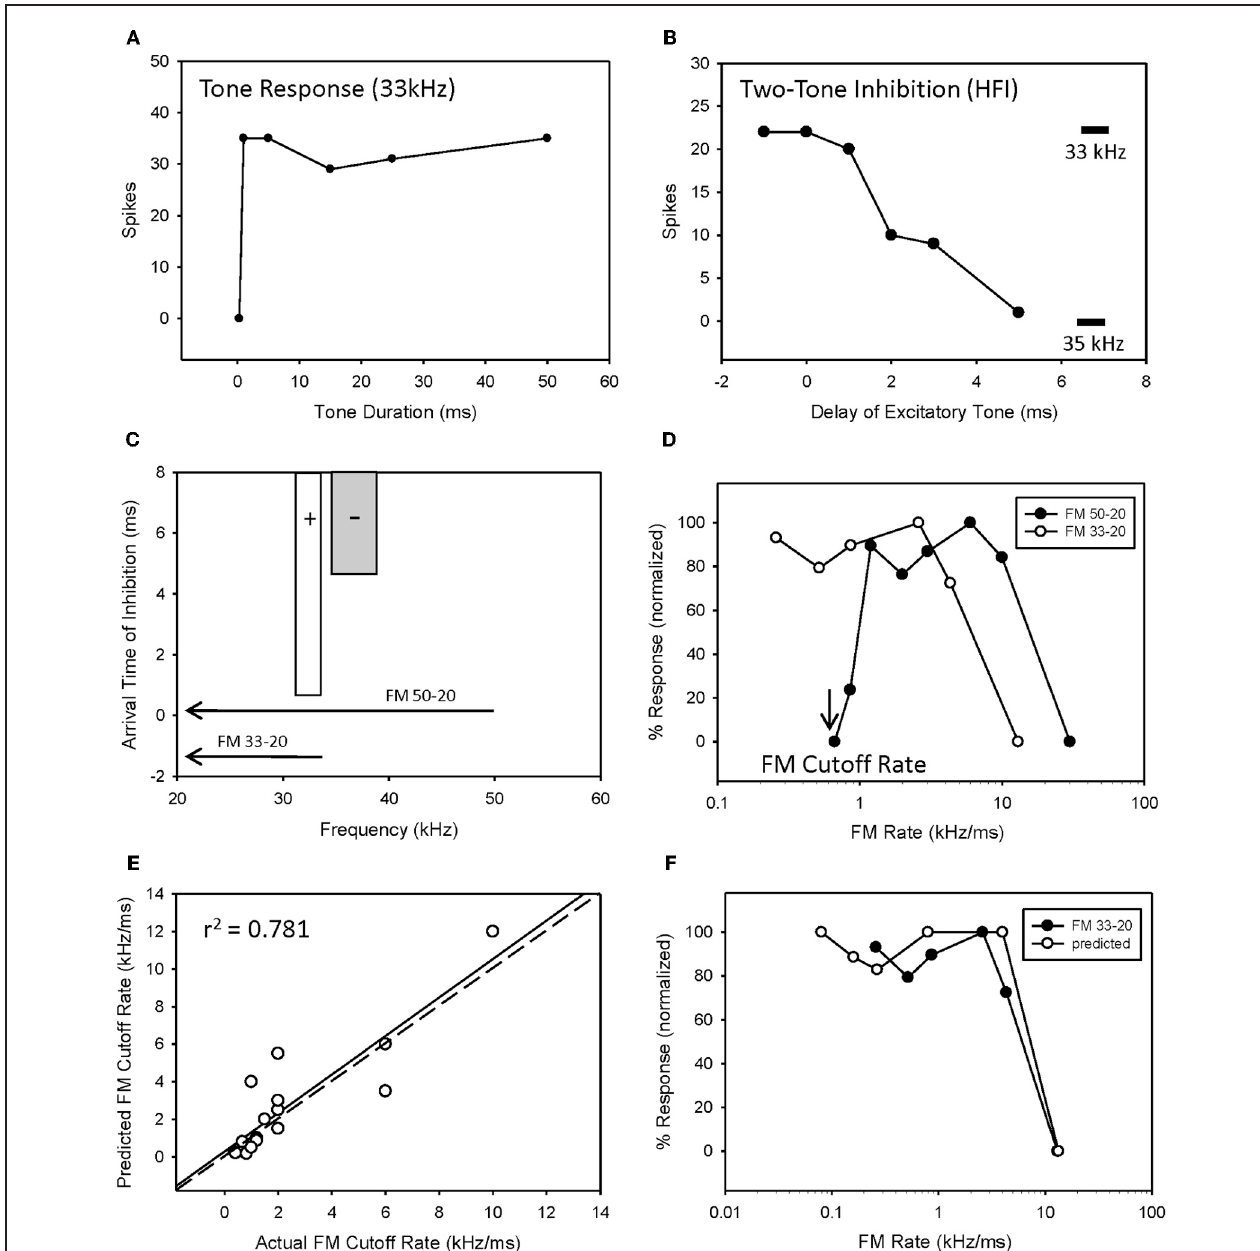
FIGURE 4 | HFI acts as a fastpass FM rate filter. Neuron exhibiting longpass duration tuning for tones (A) and a delayed HFI (B) . FM sweep responses were compared both with and without the contribution of HFI (C) . Removal of HFI converted the FM rate response from bandpass to slowpass (D) .